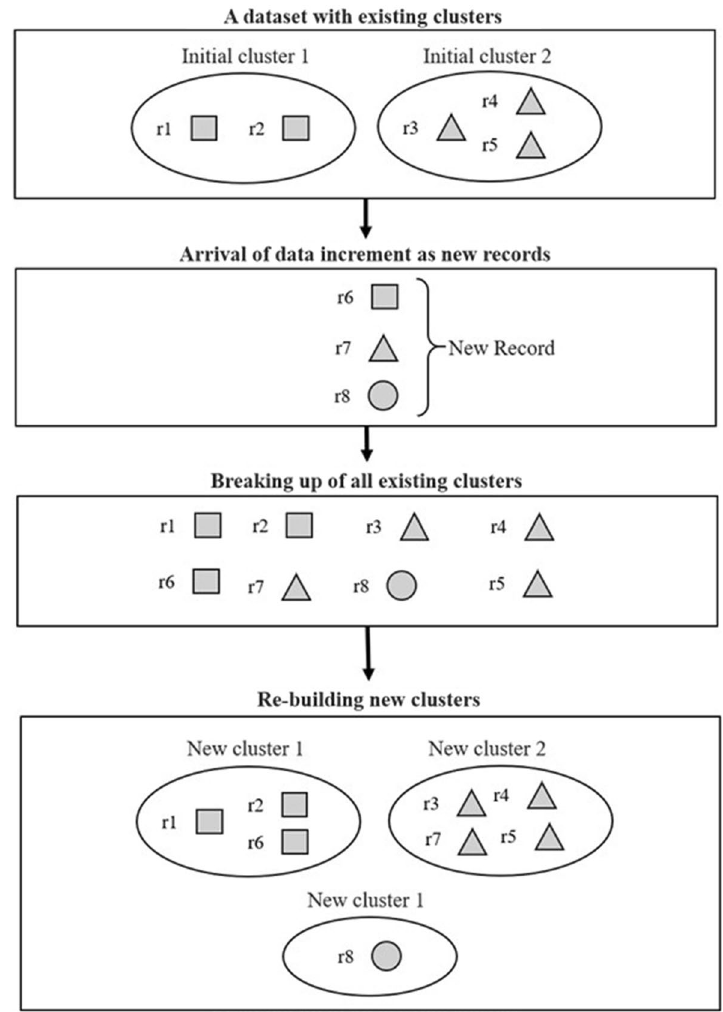
Fig. 3 Stages of batch record